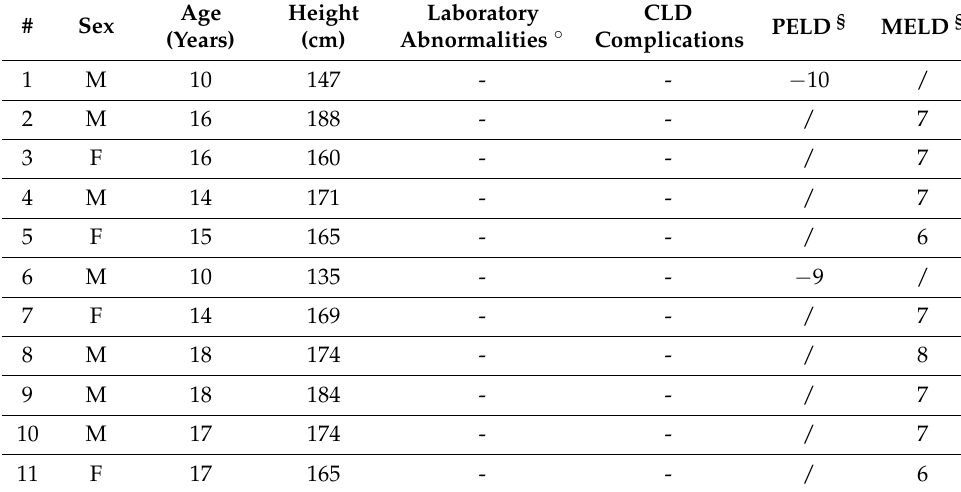
◦ Abnormal values out of the normal range. - = not present. § = Freeman2002. PELD = Paediatric End-stage Liver Disease. MELD = Model for End-stage Liver